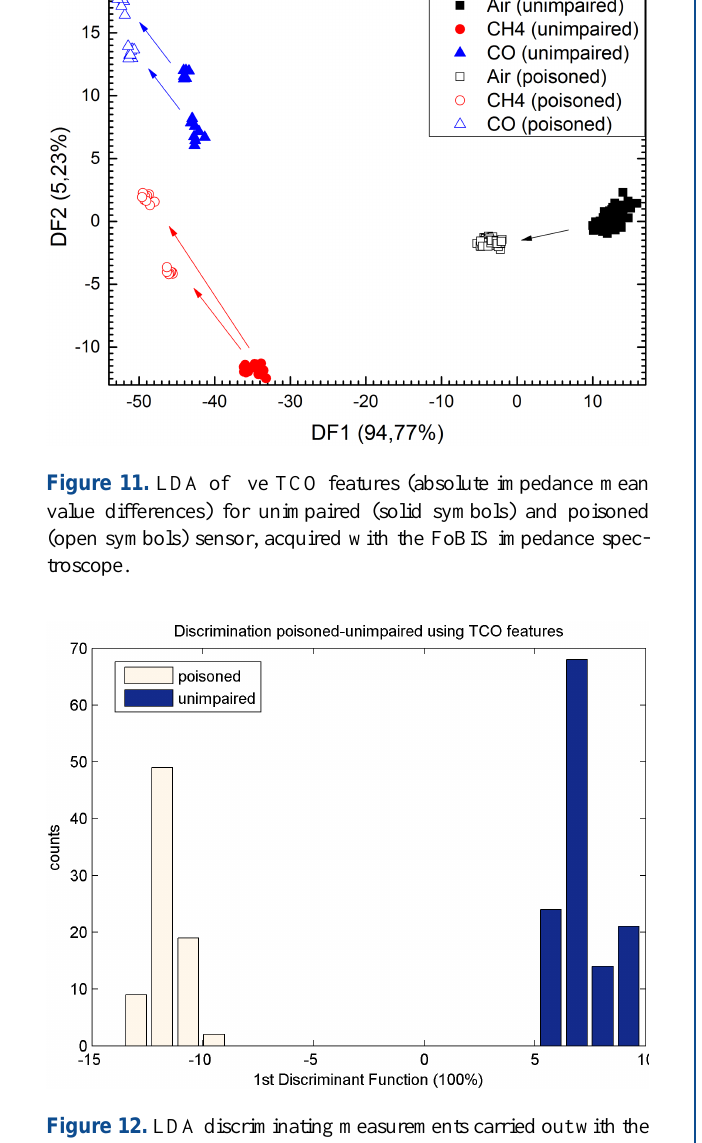
Figure 12. LDA discriminating measurements carried out with the poisoned (bright bars) and unimpaired (dark bars) sensor using five TCO features (absolute impedance mean value differences). The data were acquired using the FoBIS impedance spectroscope; mea- sured conditions are pure air plus two concentrations each of CH 4 (550, 1100ppm) and CO (50, 100ppm), all at